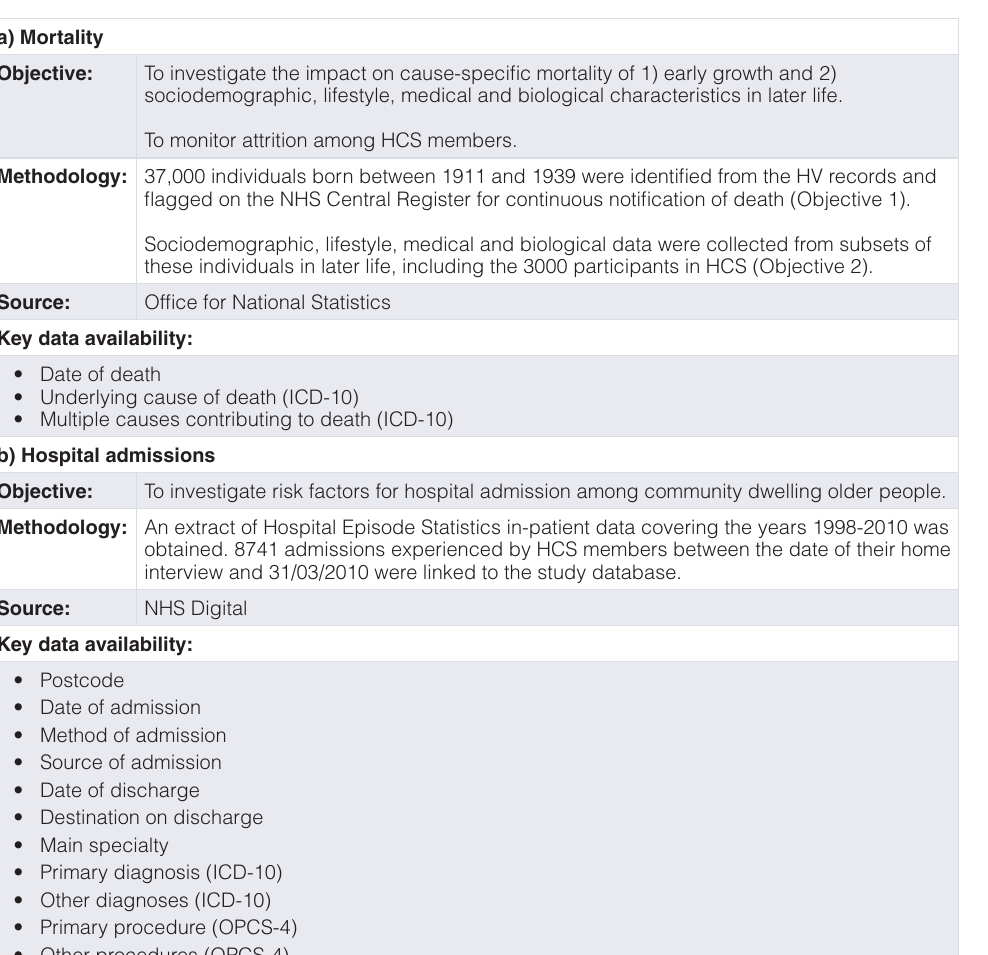
Table 12. Routinely collected data for Hertfordshire Cohort